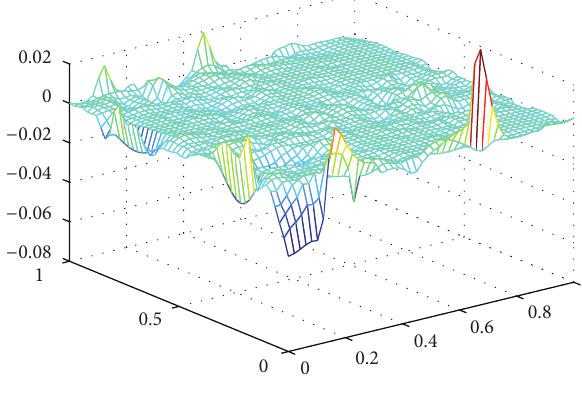
Figure 12: The error graph of